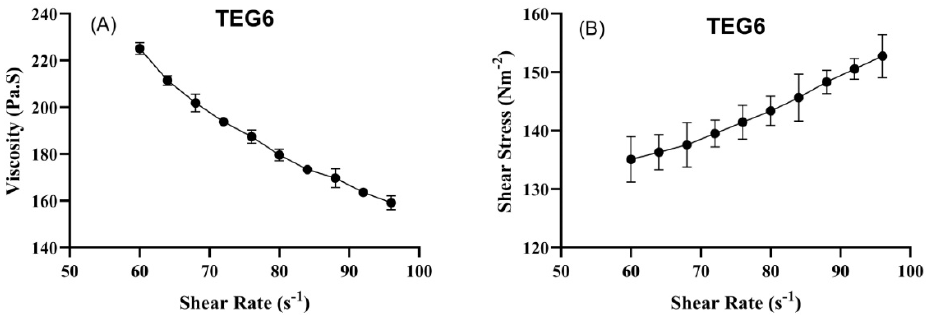
Figure 4. Rheograms of TEG6 between shear rate and viscosity ( A ) and shear rate versus stress ( B ) (Mean ± SD, n = 5).